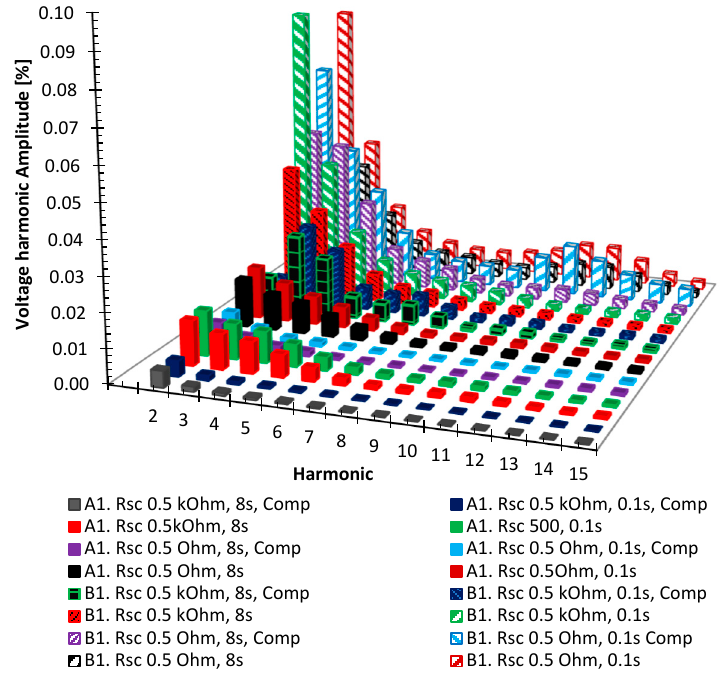
Figure 6. PCC voltage harmonic spectrum.